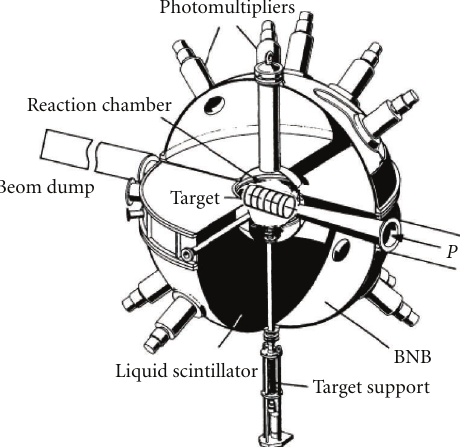
Figure 2: The experimental set up of the neutron multiplicity measurements performed by Hilscher et al.